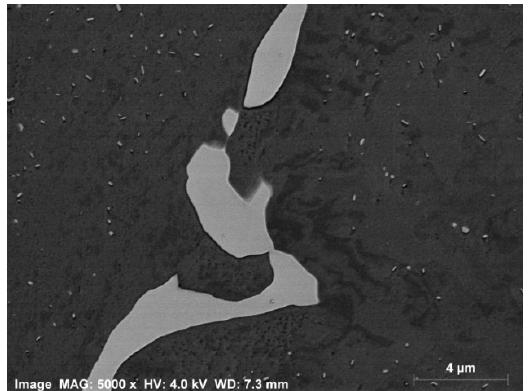
Figure 12. An example of a back-scatter electron scanning electron microscopy (BSE SEM) image of the dispersoid assessments. The image is taken from alloy 6082 after homogenization with a slow heating rate.